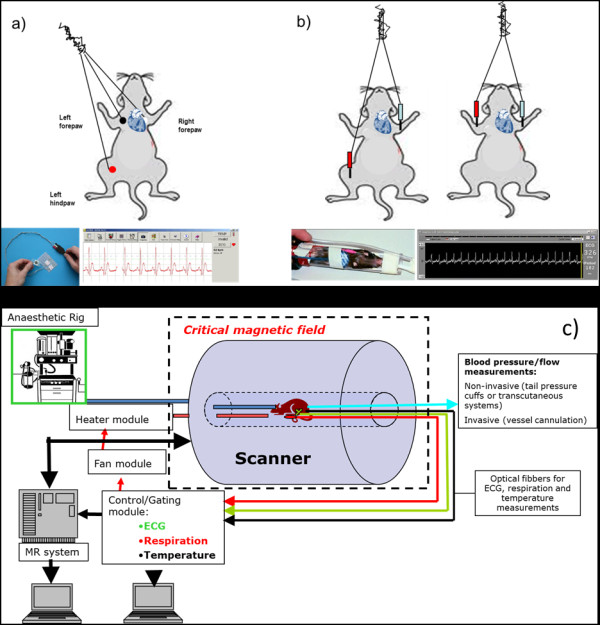
 ECG electrodes systems. (a) System BioVet™ (©m2m Imaging Corp, Newark, USA): the carbon fibre electrodes are applied directly in contact with the cleaned and shaved chest skin and applied with gel electrode so that a minimal impedance electrical connection is made with the electrode. (b) Model 1025 small animal monitoring and gating system (Small Animal Instruments, Inc., Stony Brook, NY, USA): the ECG system used for the MRI scanners uses sub-dermal needle electrodes, pads or surface electrodes. The placement of the electrodes is typically in or on the right forepaw and the left hind pore, or electrodes are placed in the forepaw as long as it is across the heart plane. All the wire bundles within the scanner should be taped to eliminate unwanted movement from the gradient vibration and/or air flow. (c) Schematic representation of the fMRI setting: all the equipment needs to be non-ferromagnetic, and it is connected to a module system which allows gated acquisition of images, avoiding interferences from motion due to breathing and /or heart beating. Body temperature is also regulated through a heating module (small rodent heater system; Small Animal Instruments, Inc.) to monitor and control the animal temperature during imaging. The system software continuously processes the temperature measurements and sends an optical control signal to the heater control module. The rate of change of temperature is monitored, and heater control is adjusted to regulate temperature changes. Mouse temperature variations of less than ±0.1°C can typically be obtained during magnetic resonance (MR) examination.